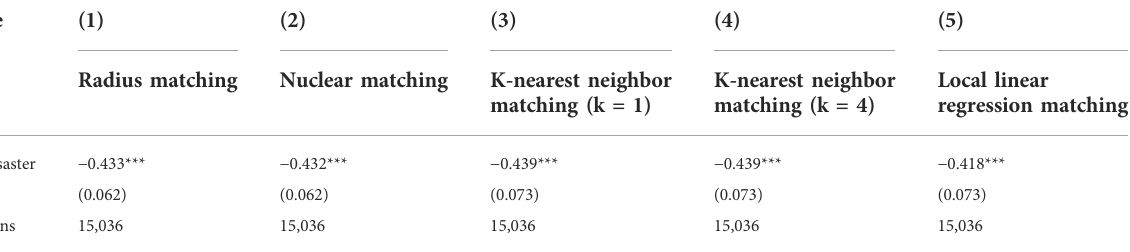
TABLE 5 Impact of natural disasters on household wealth (considering self-selection).